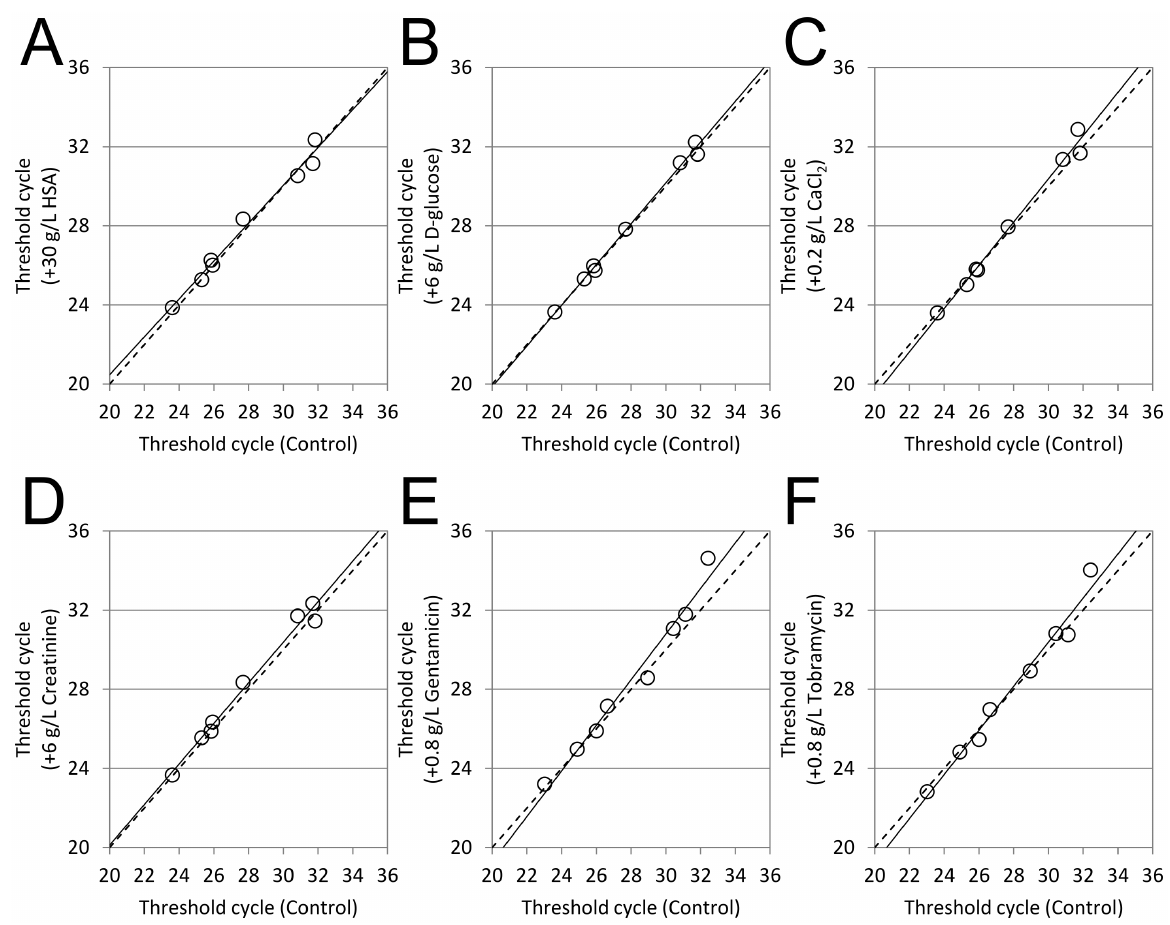
Figure 4. Effect of Urinary Component to EMV mRNA Quantification. Urine sample was obtained from a healthy donor. 30 g/L human serum albumin (A), 6 g/L creatinine (B), 6 g/L D-glucose (C), 0.2 g/L CaCl 2 (D), 0.8 g/L gentamicin (E) or 0.8 g/L tobramycin (F) was added to the sample. Ten mL urine samples were processed and eight mRNA ( ACTB , GAPDH , NPHN , PDCN , SLC12A1 , UMOD , ALB , AQP2 ) were quantified in triplicate as described in Materials and Methods. Mean Ct values of the chemical supplemented samples were plotted against those of the original sample (control). Solid lines are linear regression curves; their formulas are A. y=0.958 x + 1.307 (R 2 =0.984), B. y=1.025 x 2 0.383 (R 2 =0.985), C. y=1.031 x 2 0.753 (R 2 =0.995), D. y=1.093 x 2 2.405 (R 2 =0.988), E. y=1.152 x 2 3.782 (R 2 =0.975), and F. y=1.115 x 2 3.068 (R 2 =0.978), respectively. Perforated lines are diagonal lines to indicate perfect matches of RNA profiles.